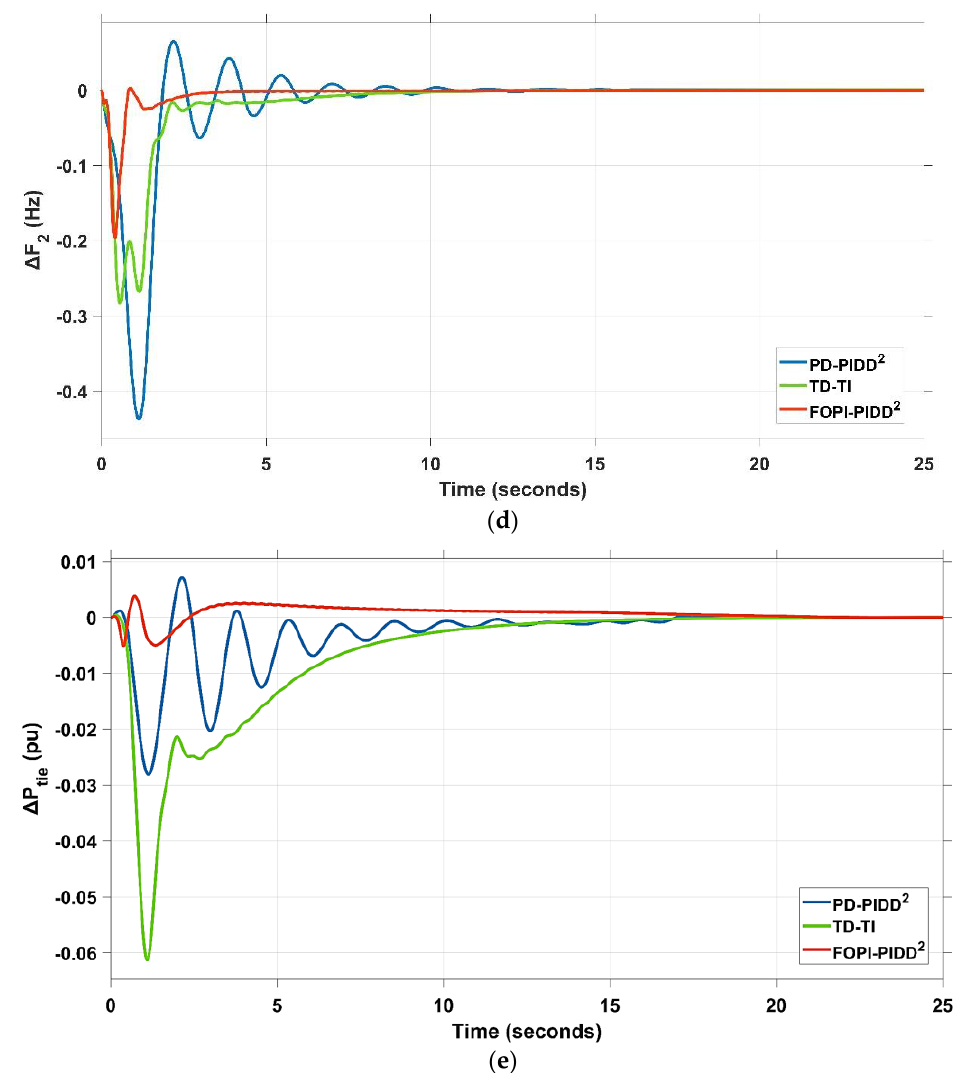
Figure 29. Comparison of PD–PIDD 2 , TD–TI, and FOPI–PIDD 2 optimized by DO algorithm for scenario 7: ( a ) V 1 , ( b ) V 2 , ( c ) ΔF 1 , ( d ) ΔF 2 , and ( e ) ΔP tie .